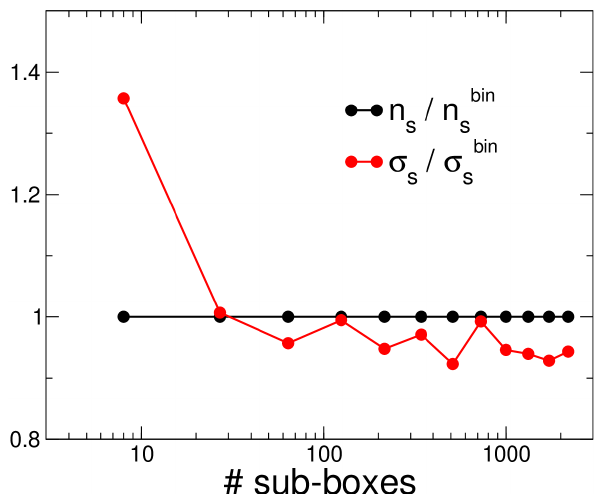
Figure 7: Average number of swaps n sec. 3.1 into sub-boxes, and their standard deviation σ calculated in the simulations to values expected from the binomial distributions